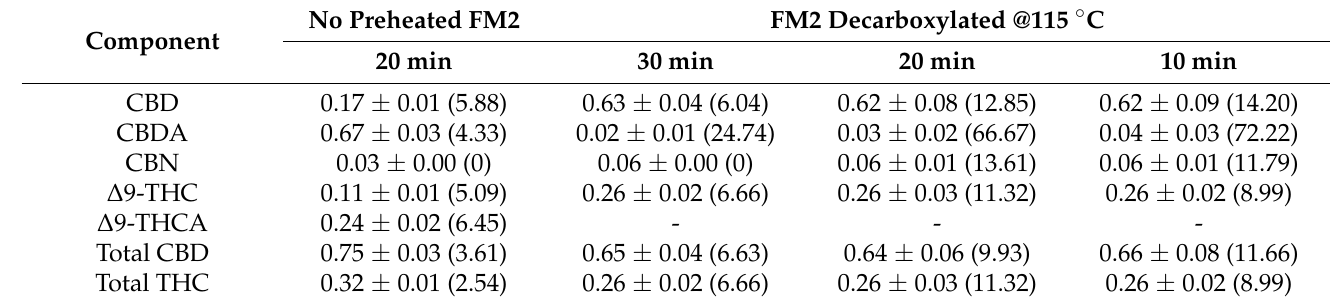
Table 4. Cannabinoid content in oily samples prepared by ultrasonic assisted extraction using no heat treated FM2 (t = 20 min) or FM2 decarboxylated at 115 ◦ C. Aliquots of 20 mL sample were sonicated (amplitude 60%) for different time-period (n = 3, expressed as % w/w